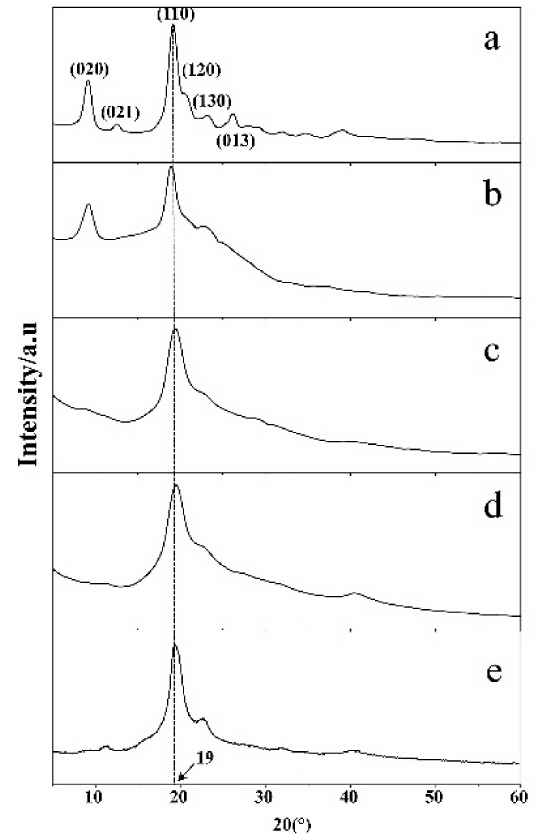
Figure 3. Wide-angle X-ray diffraction patterns of the chitin powder ( a ), ChWs film ( b ), PVA/ChWs composite films ( c ), pure PVA films ( d ) and heat treated PVA/ChWs composite films ( e